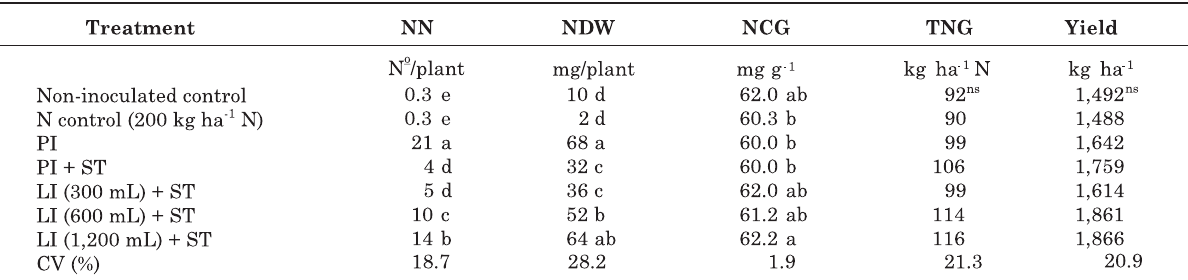
Table 6. Nodule number (NN) and dry weight (NDW) at the V4 stage, N grain content (NGC), total N grain content (TNG), and grain yield at the harvest of soybean inoculated with peat (PI) or liquid (LI) inoculant, with or without seed treatment (ST) with fungicides and micronutrients (1) . Experiment conducted in Avaré, São Paulo, in the 2001/2002 growing season, in a soil treated with inoculant for the first time (< 10 1 cells g -1 of soil) (2)